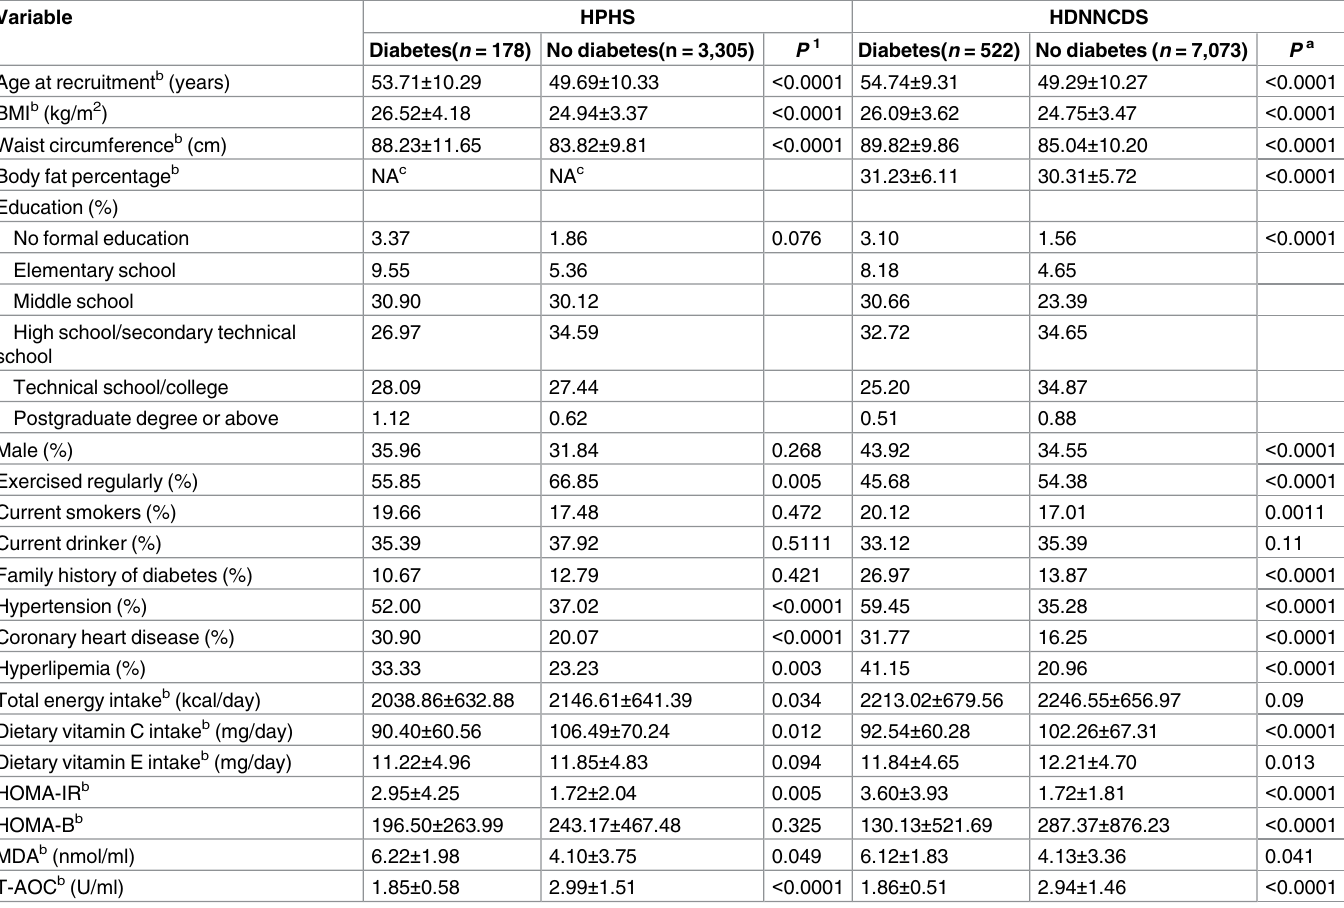
Table 1. Baseline characteristics of participants according to type 2 diabetes status in the Harbin People’s Health Study (HPHS, 2008) and in the Harbin Cohort Study on Diet, Nutrition and Chronic Non-communicable